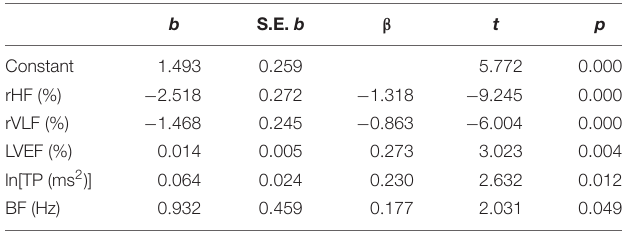
TABLE 7 | Multiple regression analysis with predictors for the ratio of short-term to long-term scaling